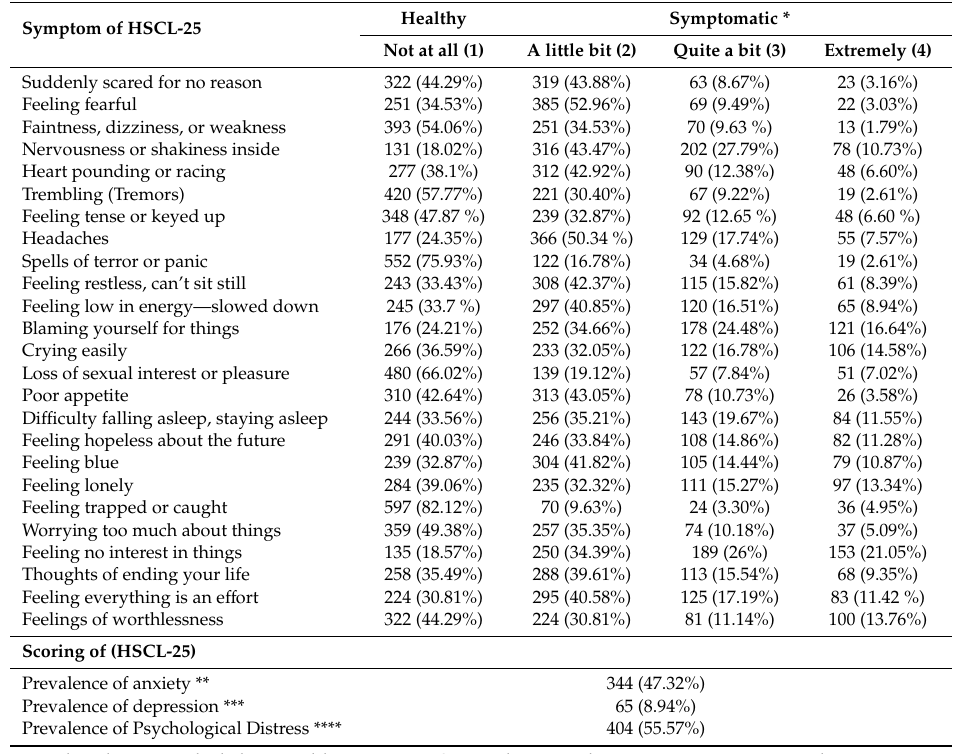
Table 3. Distribution of Hopkins Symptom Checklist—25 items (HSCL-25) of the study participants. Healthy Symptomatic * Symptom of HSCL-25 Not at all (1) A little bit (2) Quite a bit (3) Extremely (4) Suddenly scared for no reason 322 (44.29%) 319 (43.88%) 251 (34.53%) 385 (52.96%) 393 (54.06%)